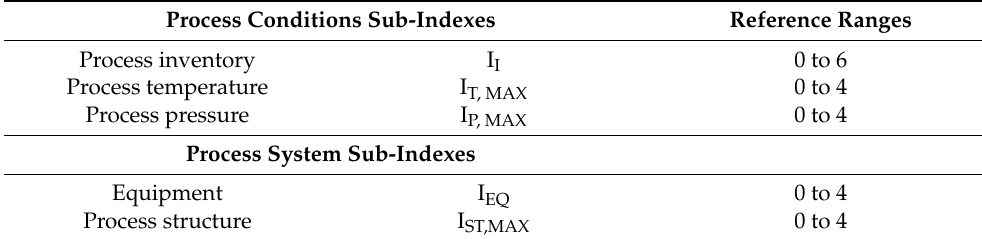
Table 2. Sub-indexes for calculating Process Safety Index